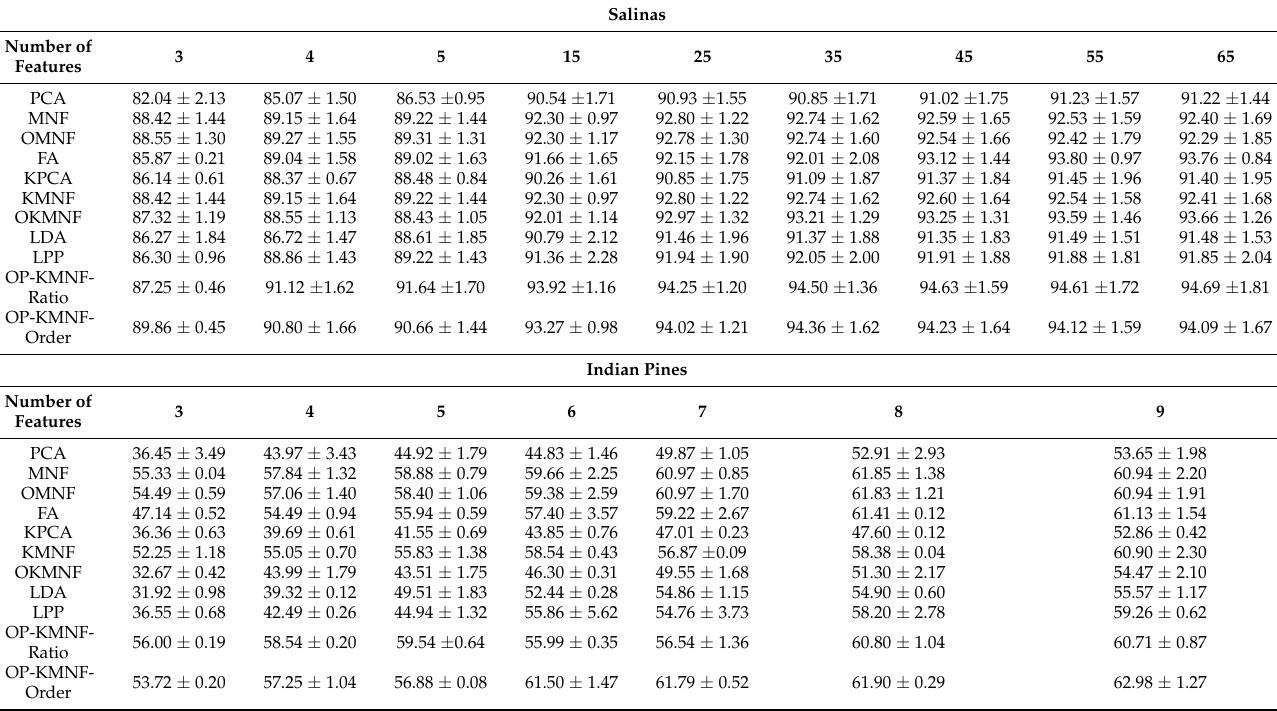
Table 5. The average accuracies of support vector machine (SVM) classification in the Salinas, Indian Pines, and Xiong’an datasets after different dimensionality reduction (DR) methods. All the results are